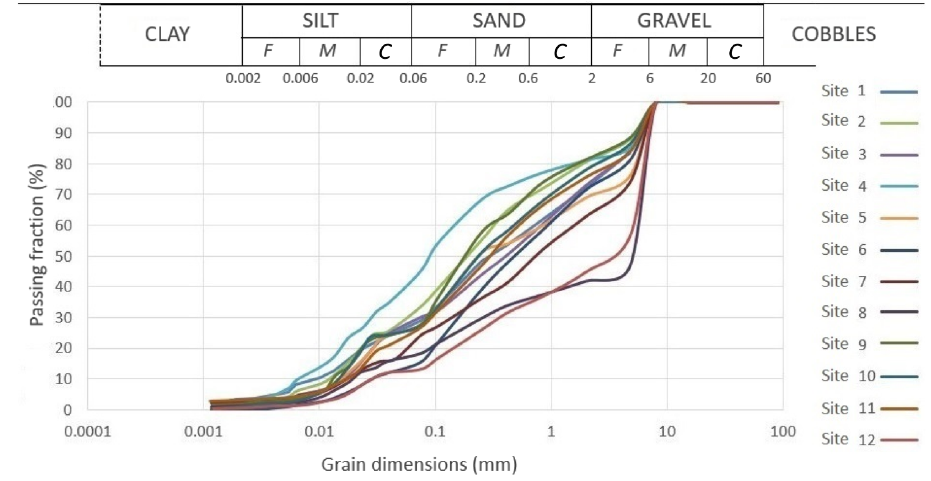
Figure 4. Grain size distributions of soil samples (F is fine, M is medium and C is coarse). Table 2. Spatialized geotechnical parameters of each lithological class as input for the HIRESSS